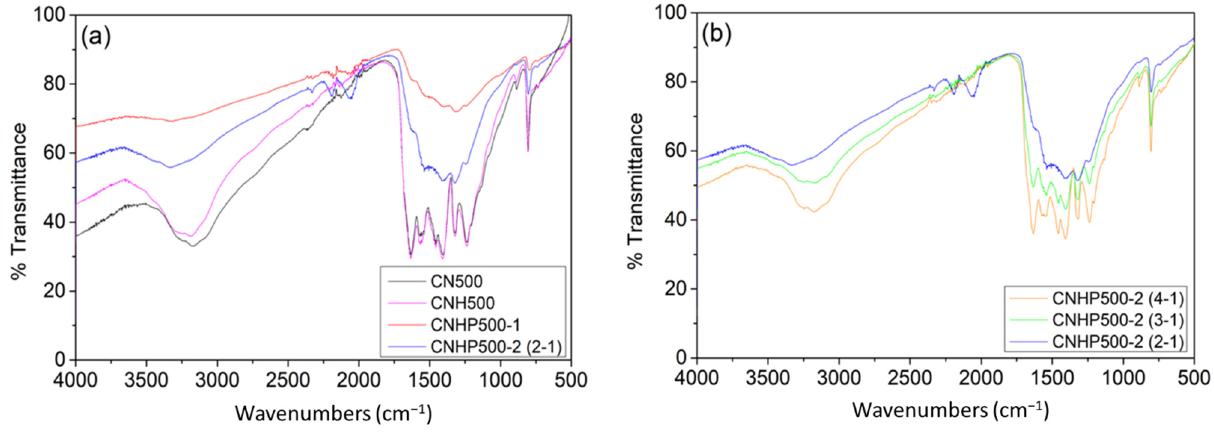
Figure 3. ( a ) FTIR spectra for sample CN500, CNH500, CNHP500-1, and CNHP500-2(2-1). ( b ) FTIR spectra for sample CNHP500-2(4-1), CNHP500-2(3-1), and CNHP500-2(2-1).